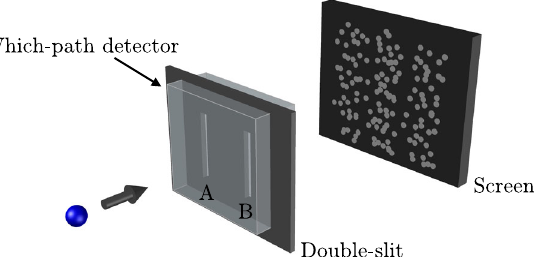
FIG. 2. Single-particle double-slit experiment in the presence of a which-path detector (transparent box). A single particle (blue ball) passes through a double slit and is detected on a screen. The amount of information on the particle ’ s path, obtained by the which-path detector, determines the visibility of the interference pattern on the screen.